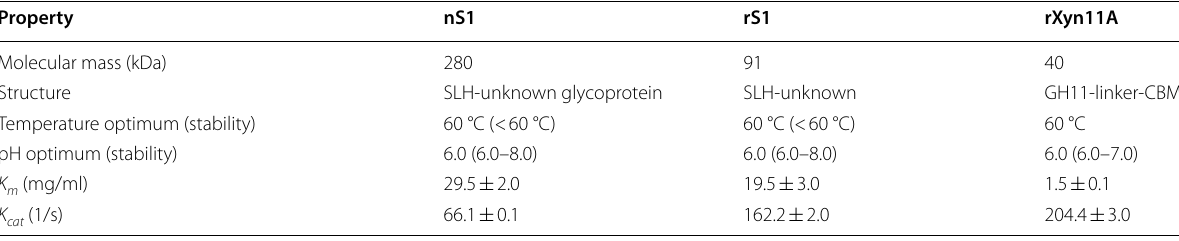
Soluble birchwood xylan was used as substrate Data are presented as the means from three independent experiments. Errors represent standard deviations (n SLH surface layer homology domain, GH11 glycosyl hydrolase family 11, CBM36 family 36 carbohydrate-binding module